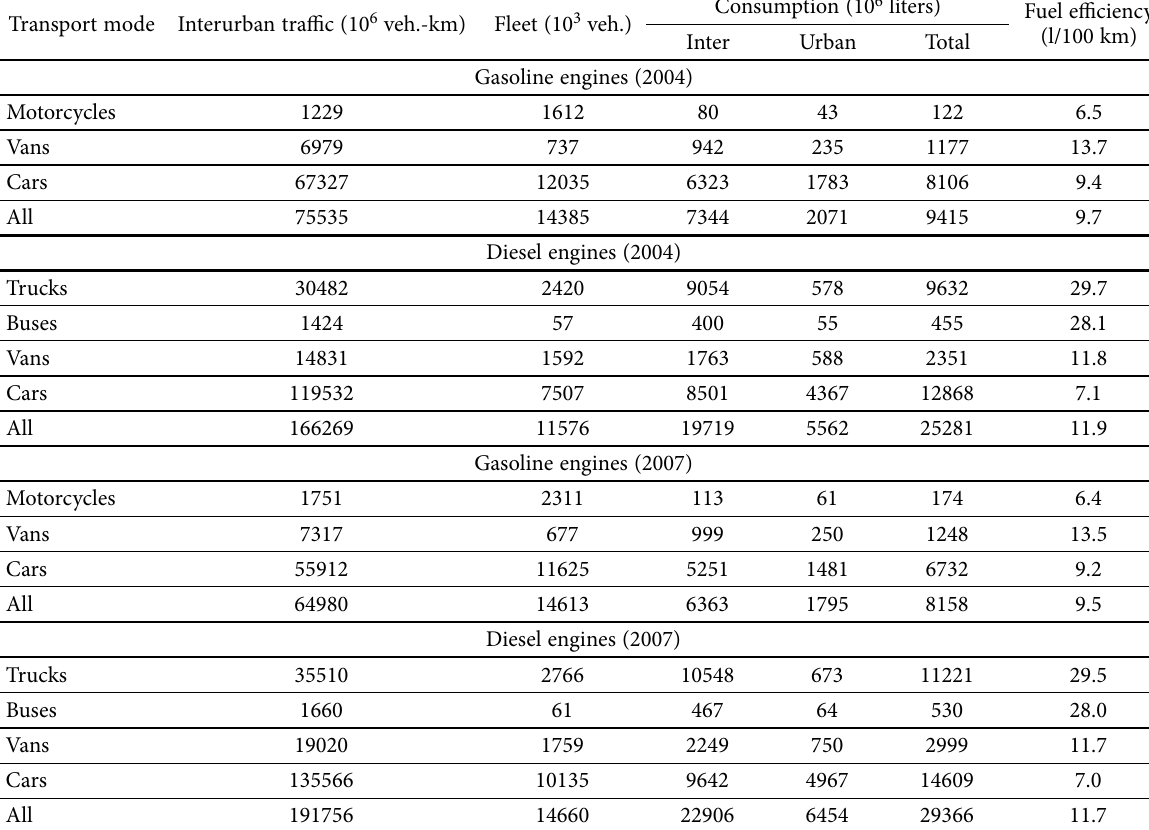
Table 1. Distribution of traffic (10 6 vehicle-km), fleet (10 3 vehicles), fuel consumption (10 6 liters) and fuel efficiency (l/100km) in road transport in Spain by fuel and vehicle types, 2004–2007 (source: self-preparation from MF (2009a), MF (2009b), DGT (2009) and AT (2009)) Transport mode Interurban traffic (10 6